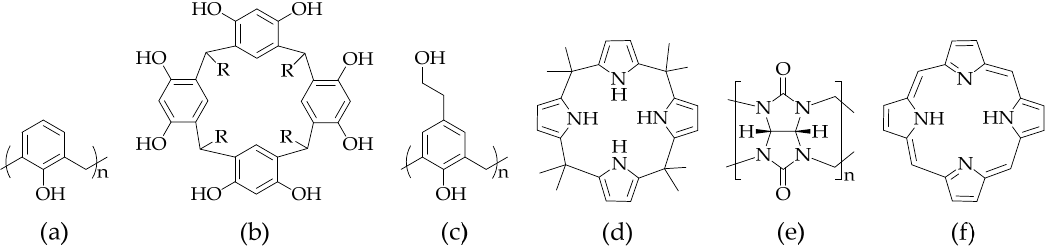
Figure 1. Supramolecular scaffolds used in the development of antioxidants ( a ) calix[n]arene; ( b ) resorcinarene; ( c ) calixtyrosol; ( d ) calixpyrrole; ( e ) cucurbit[n]uril; ( f ) porphyrin.